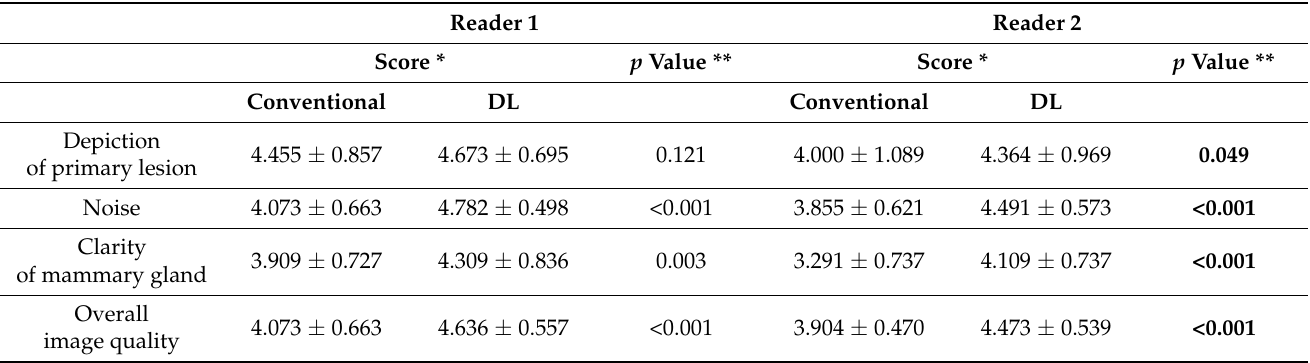
Table 2. Visual analysis scores.